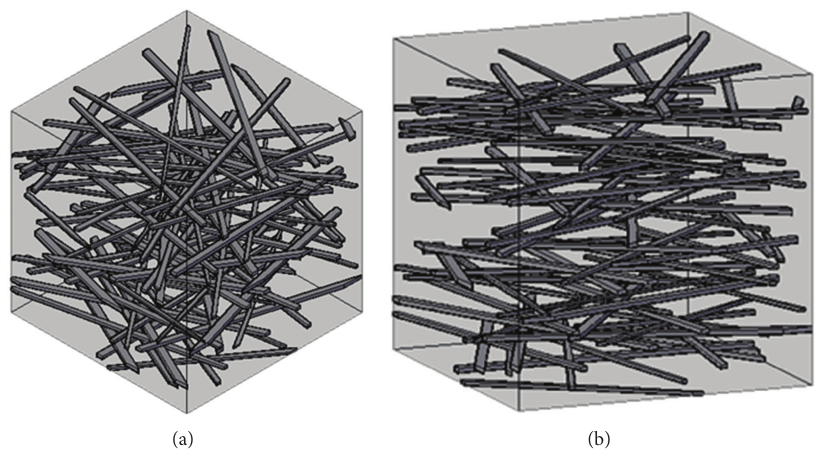
Figure 10: An example of 3D structures of